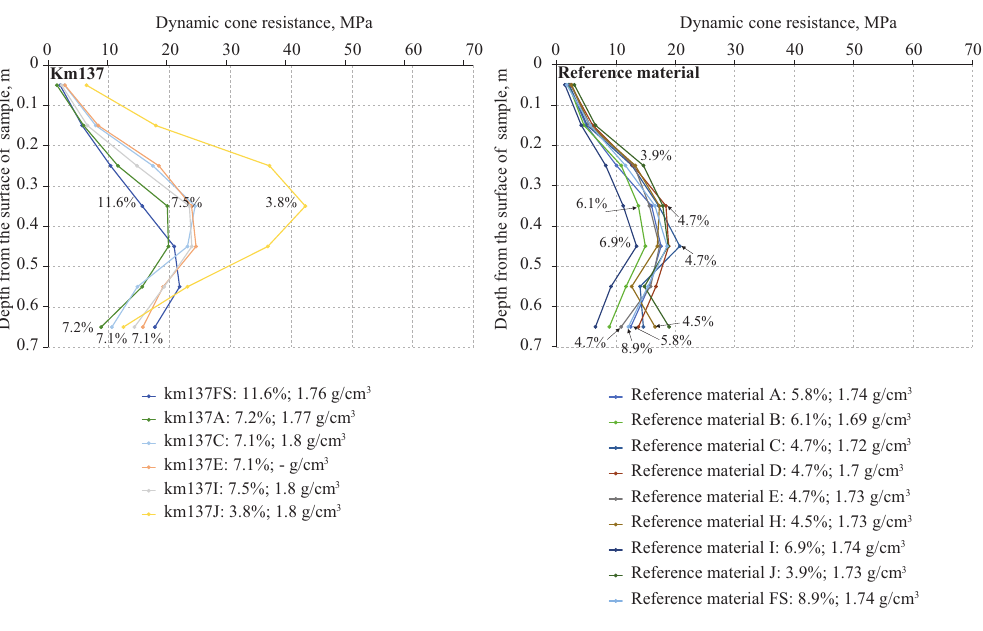
Figure 7. The dynamic cone resistance of entire samples at varying moisture content